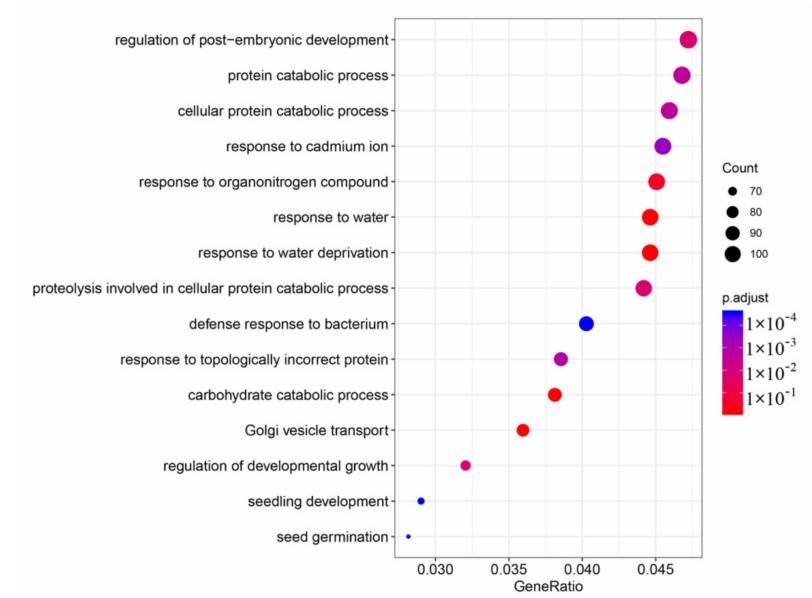
Figure 5. Gene ontology (GO) enrichment analysis of differentially expressed genes